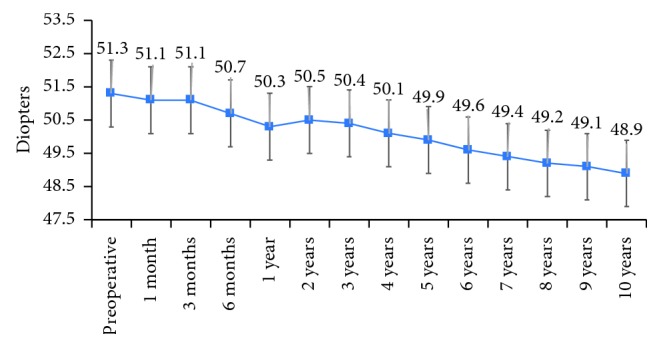
Decrease of Kmax during the follow-up.